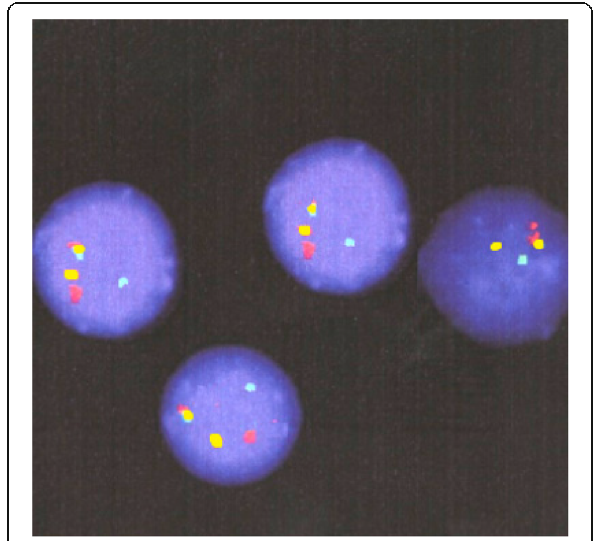
Fig. 3 An interphase FISH analysis applied for follow-up using LSI double fusion (DF) probe BCR/ABL positive for t(9;22) (q34;q11), 2 yellow signal represents the typical fusion signal of translocation in addition to one green signal (BCR) and one red signal (ABL)